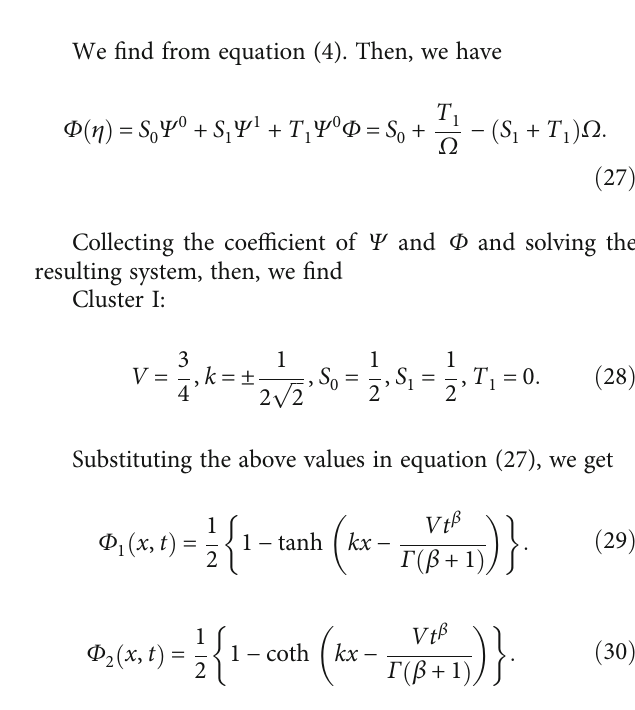
ð x , t Þ : (a) real three-dimensional shape, (b) complex three-dimensional shape, (c) 1